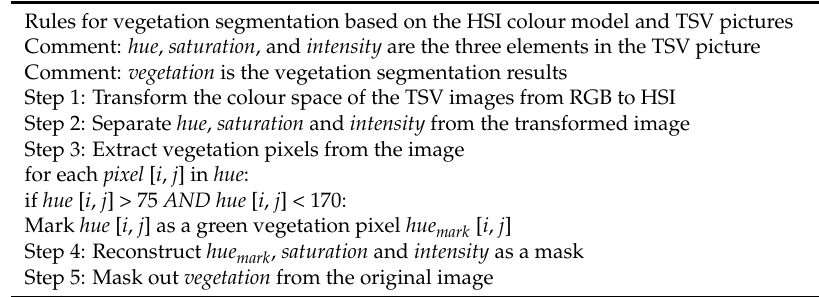
Table 1. Rules for vegetation segmentation based on the HSI (Hue, Saturation and Intensity) colour model and Tencent Street View (TSV)